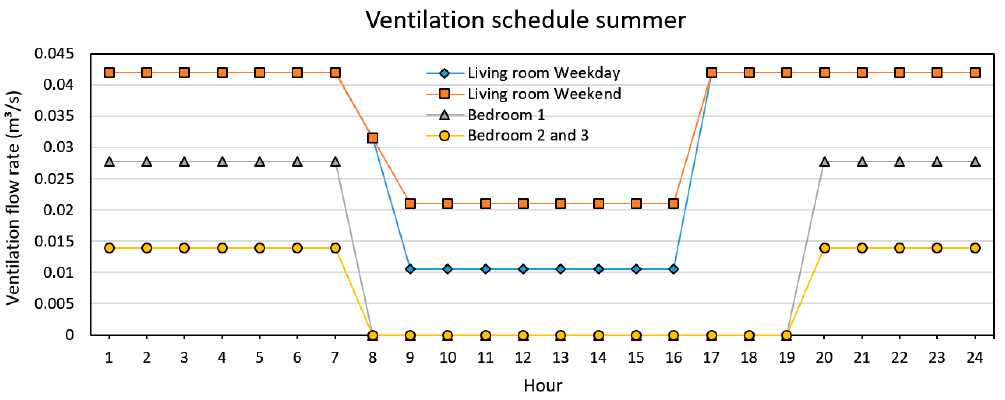
Figure 27. Ventilation schedule of each room during summer.